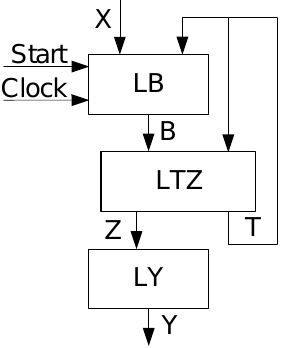
Figure 2. Structural diagram of MPY Mealy